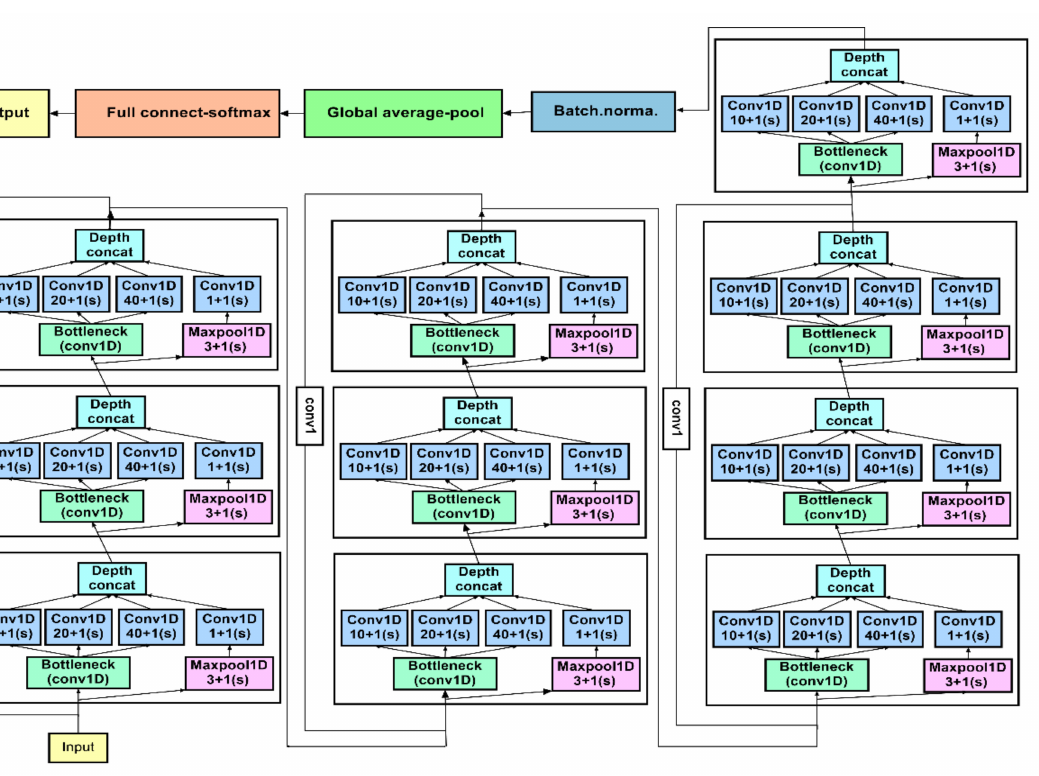
Figure 2. Inception Time